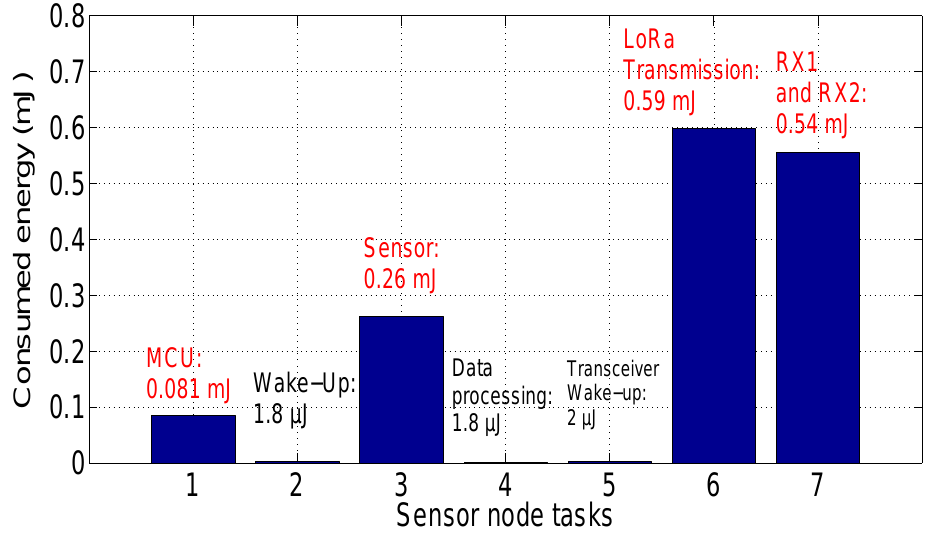
Figure 19. Energy consumption of sensor node: Scenario 3.